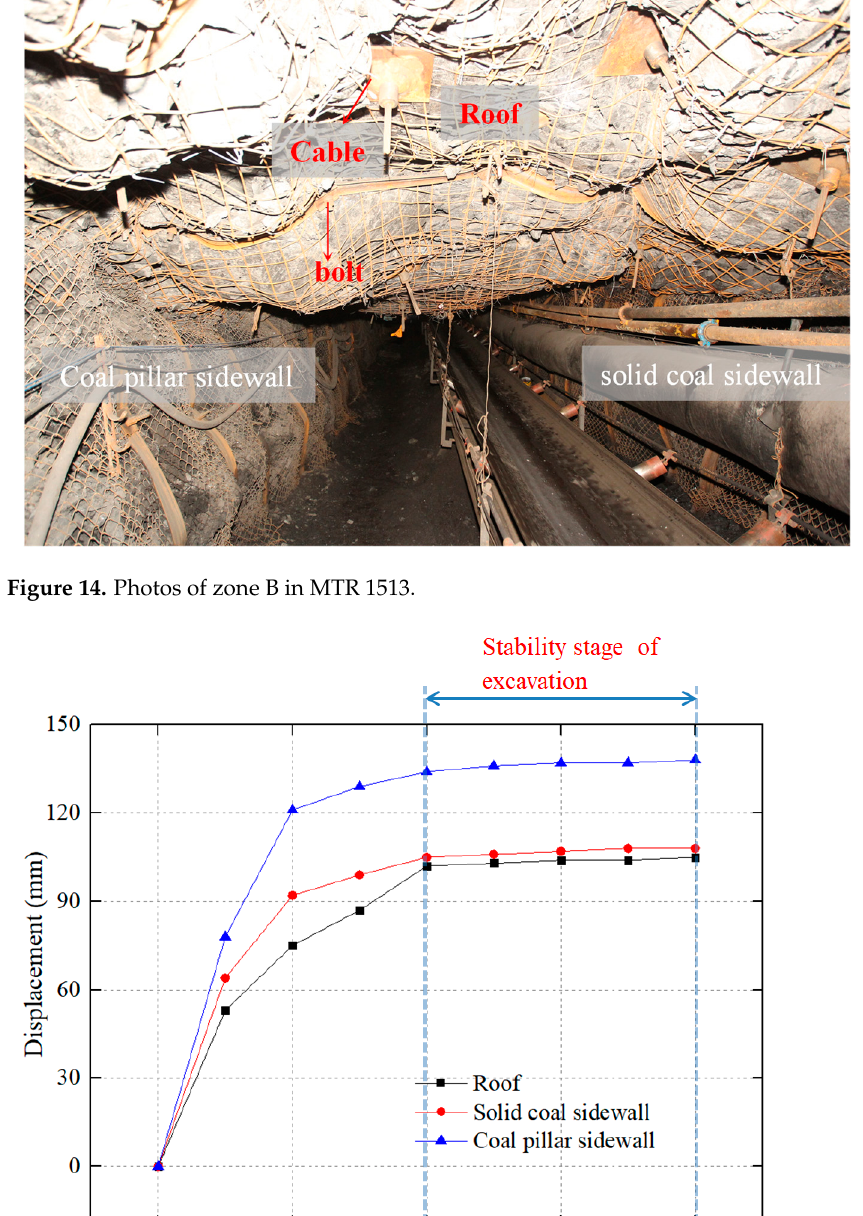
Figure 14. Photos of zone B in MTR 1513.